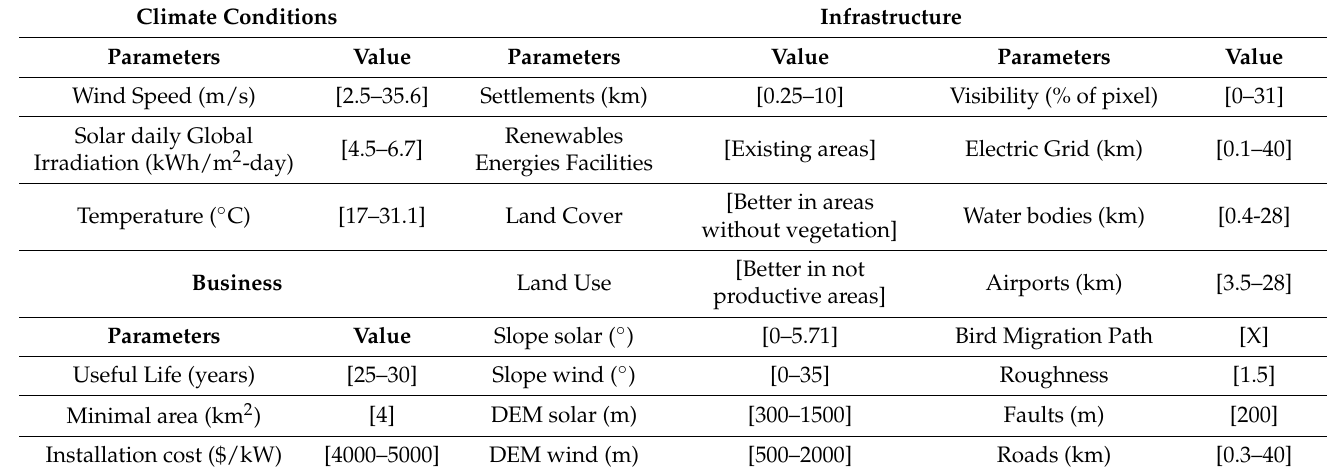
Table 1. Parameters extracted from the review of articles, adapted to the layers structure. Climate